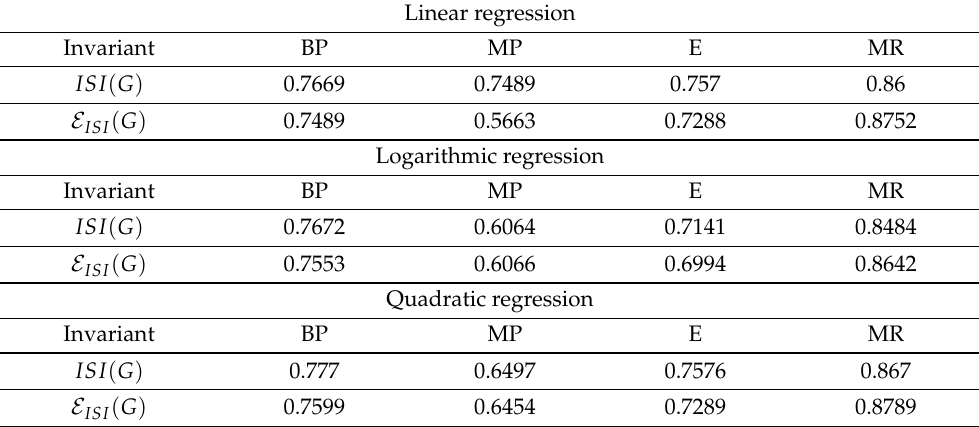
Table 3. R 2 of Anticancer Drugs with the ISI -Index (Energy) of their Chemical Structures. Linear